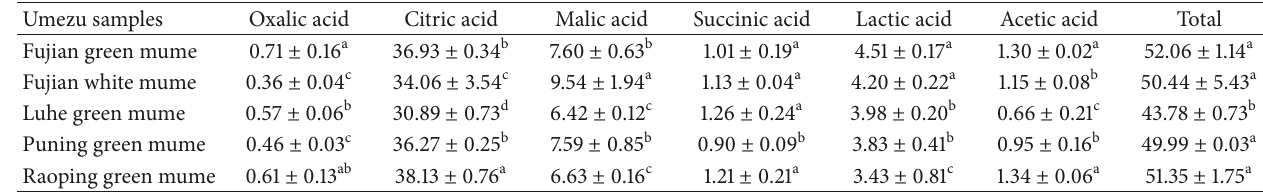
Table 2: Predominant organic acids of umezu from different factories (g/L).